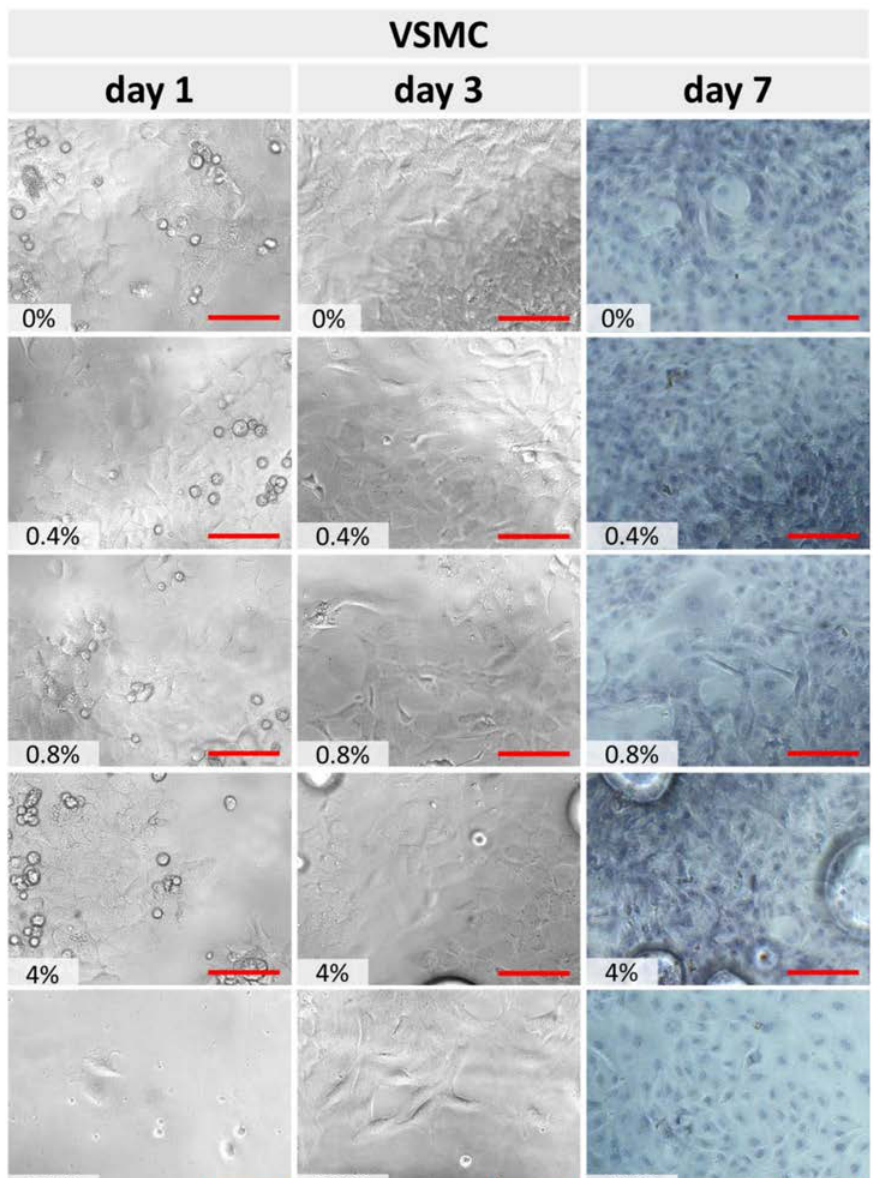
Figure 6. Optical microscopy of VSMCs after 1, 3 and 7 days of culture on an unmodified cPOC surface (0 wt.% of GSH) and on cPOC modified with different concentrations of GSH (0.4, 0.8 and 4 wt.%). Cells cultured on TCPS served as a control. After day 7, the cells were stained with hematoxylin and eosin. Scale = 200 µm (red line).